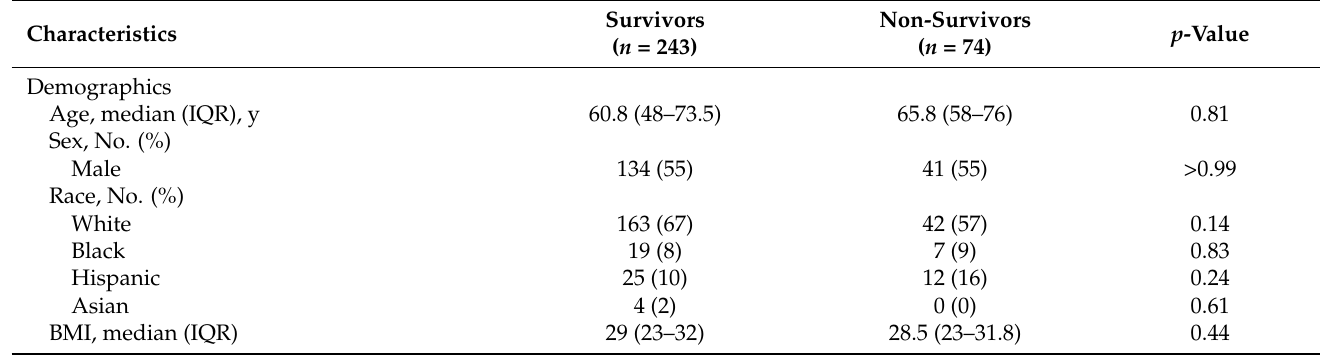
Table 1. Demographic and clinical characteristics between survivor and non-survivor